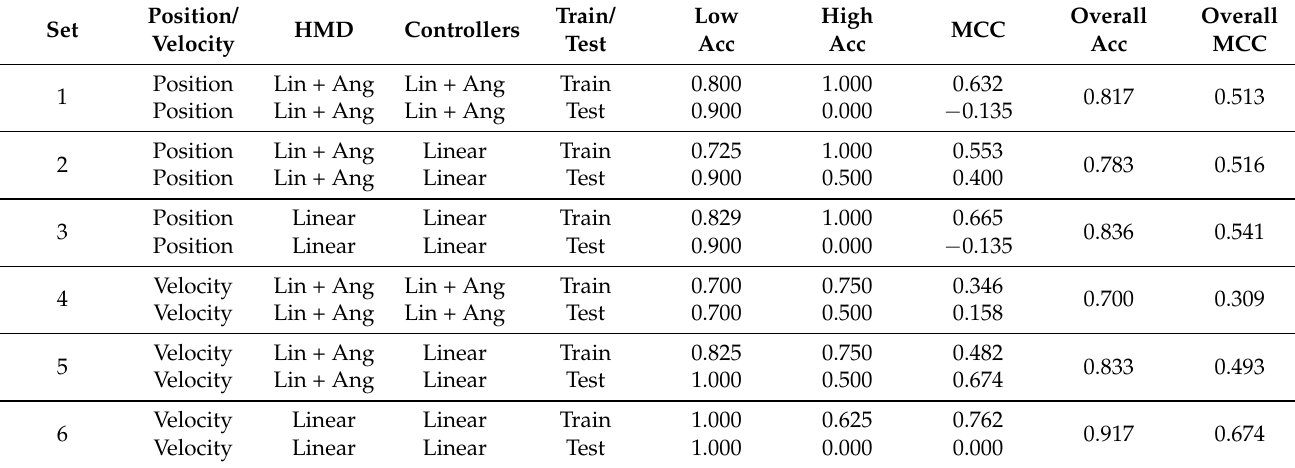
Table 5. Knowledge Acquisition prediction results. For each of the six sets of input features, the accuracy of the low- performance and high-performance predictions and the MCC are shown for both the training and testing data. Accuracy and MCC are also shown for each set of input features across the entire dataset (i.e., both the training and testing data).